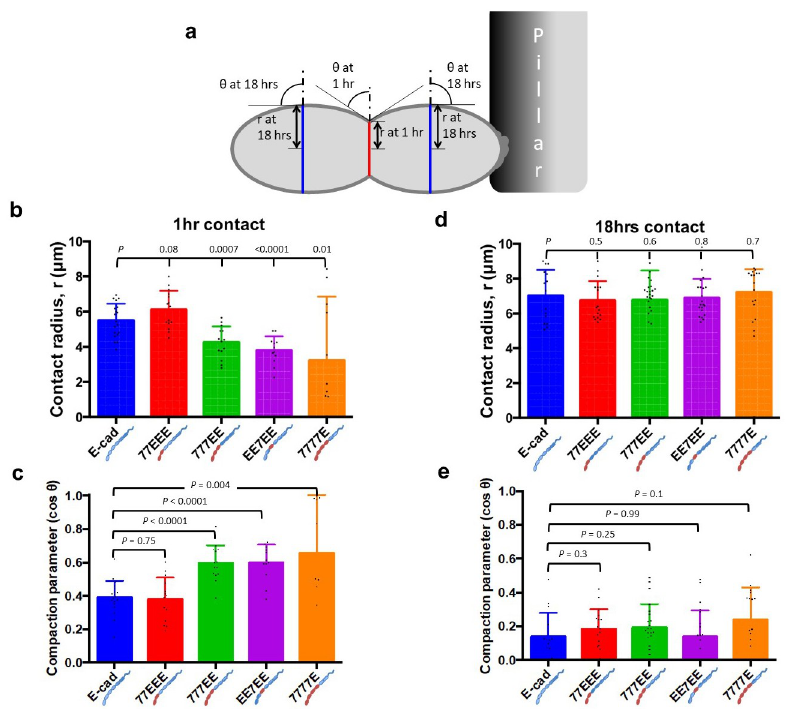
Fig 4. Contact radius and compaction parameter. (a) Drawing depicting two pre-existing (18 hrs) doublets adhering to each other through a 1-h contact. The 1-h cell-cell junction is shown in red and the pre-existing (18-h) junctions in blue. Measurements of the cell-cell contact angle “ θ ” and the contact radius “r” in 1 hr and pre-existing (18 hrs) doublets are illustrated. (b) Histogram of contact radius at 1 hr contact (E-cad, n = 19; 77EEE, n = 15; 777EE, n = 14; EE7EE, n = 12; 7777E, n = 10). (c) Histogram of dimensionless compaction parameter (cos θ ) at 1 hr of contact (E-cad, n = 19; 77EEE, n = 14; 777EE, n = 14; EE7EE, n = 12; 7777E, n = 10). Note that, although the compaction parameter of E-cad and 77EEE groups are similar, their SFs are significantly different, as seen in Fig 2e and 2g. (d) Histogram of contact radius in pre-existing (18 hrs) doublets (E-cad, n = 15; 77EEE, n = 17; 777EE, n = 23; EE7EE, n = 21; 7777E, n = 17). Note that the mean contact radii of all groups are similar, although their separation forces (SFs) are significantly different (Fig 2f and 2h). (e) Histogram of compaction parameters of pre-existing (18 hrs) doublets (E- cad, n = 15; 77EEE, n = 17; 777EE, n = 23; EE7EE, n = 21; 7777E, n = 17). Note that the compaction parameters for E- cad and other groups are similar, even though they show significantly different SFs (Fig 2f and 2h).